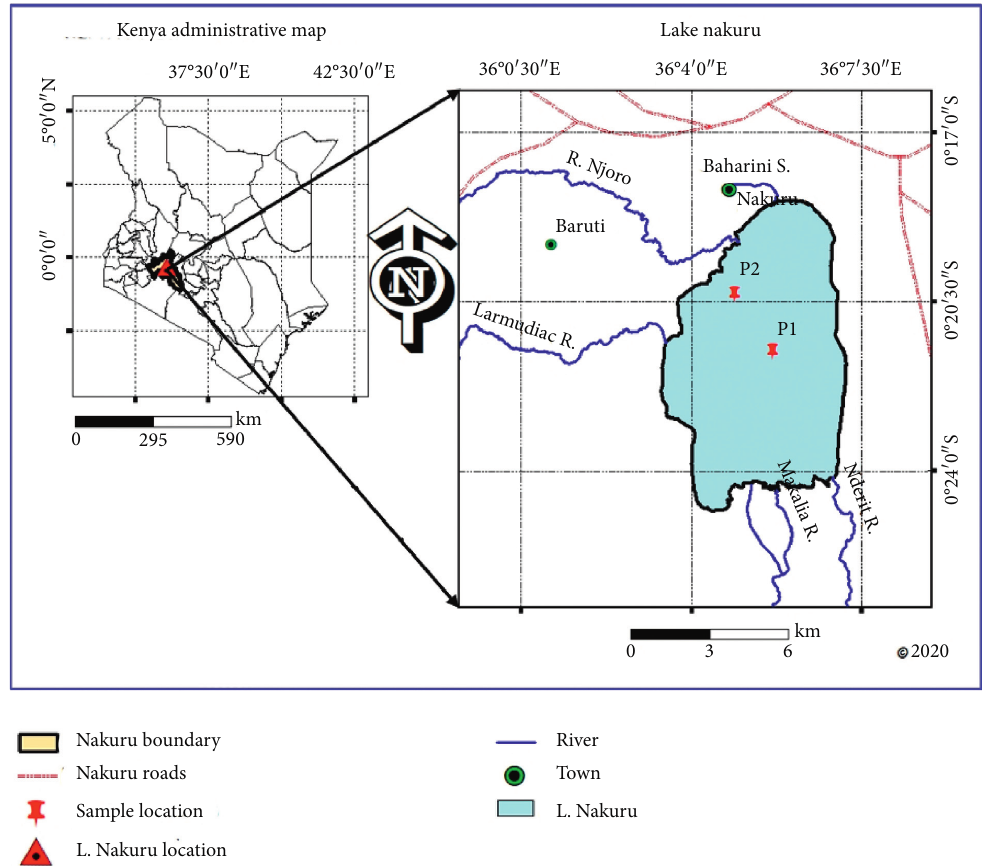
Figure 1: Lake Nakuru location map.